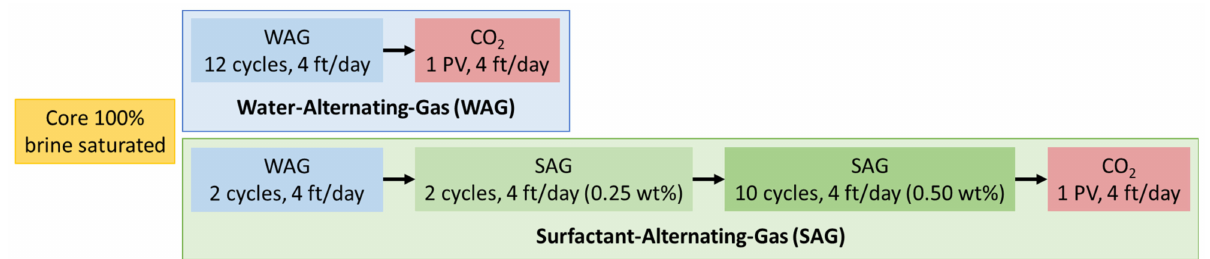
Figure 3. Experimental injection sequence for the baseline water-alternating-gas (WAG) and the surfactant-alternating-gas (SAG). The core was initially 100% saturated with brine and all injection rates were 4 ft/day. Individual WAG or SAG cycles injected 0.25 pore volumes